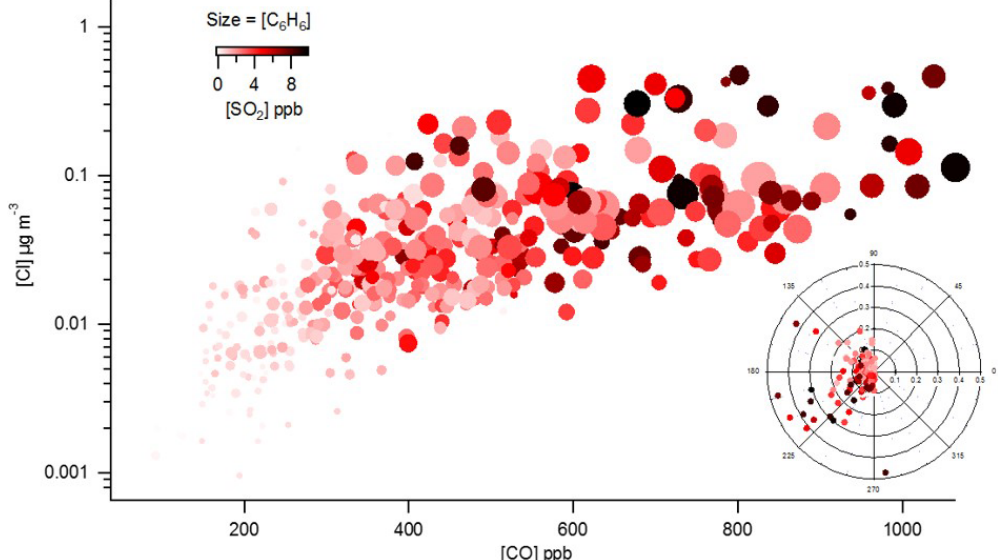
Figure 4. Correlation of particulate Cl − from the AMS measurements and CO colour coded by the SO 2 mixing ratio and size binned by increasing benzene mixing ratio. A wind rose plot illustrates the wind direction and particulate Cl − mixing ratio colour coded by SO 2 mixing ratio.